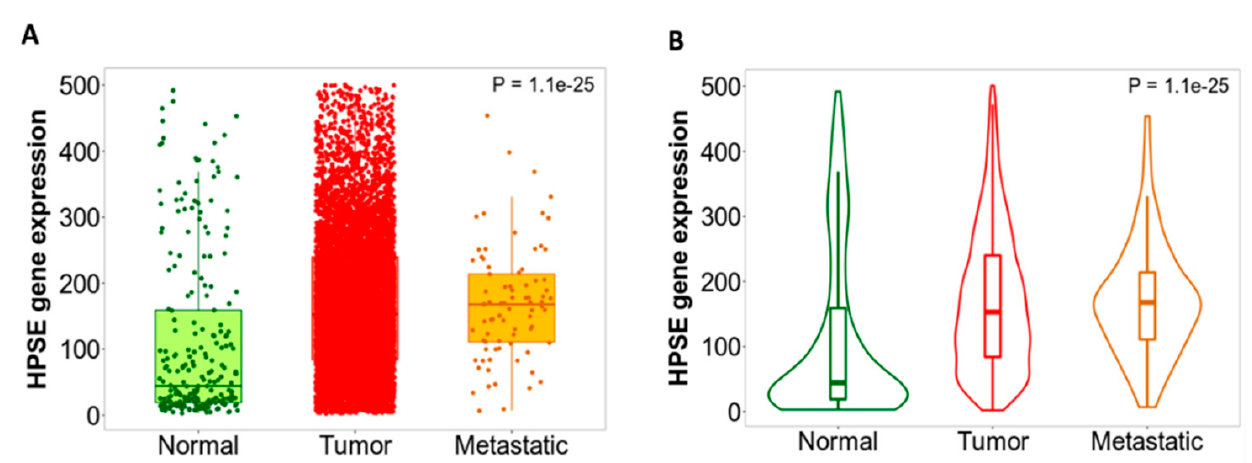
Figure 3. HPSE gene expression profile of normal mammary tissues, breast invasive carcinoma and metastatic breast tissues mining gene chip data from Gene Expression Omnibus (GEO) repository and presented as boxplot ( A ) and violin plot ( B ). Normal tissue N = 242, Tumor N = 7569, Metastatic N = 82 [59]. Table 3. The main functions of major glycolytic enzymes in cancer progression. Their prognostic value has been estimated by pan-cancer analysis in all available normal and tumor RNA Seq data from GEO, TCGA and GTex databases [59]. Sig- nificant differences of expression in tumor tissues compared to normal expression are marked with red (upregulation) and blue (downregulation) and have been computed by Mann–Whitney U test. Enzyme